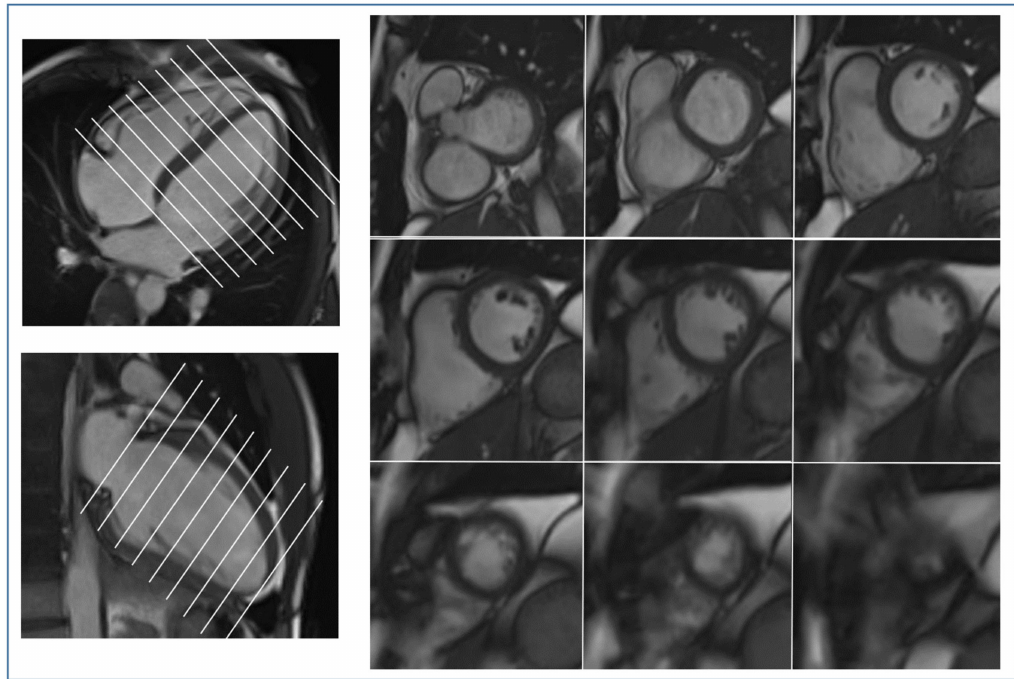
Figure 1. Measurement of left ventricular volumes and function. A stack of short axis images is used for semi-automated delineation of epicardial and endocardial borders on both end-systolic and end-diastolic